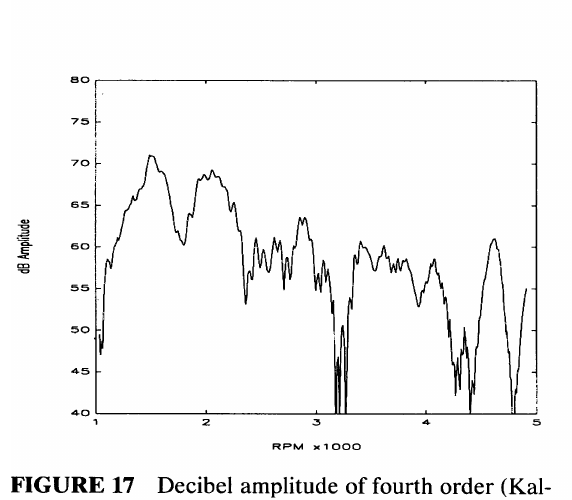
FIGURE 17 Decibel amplitude of fourth order (Kal man